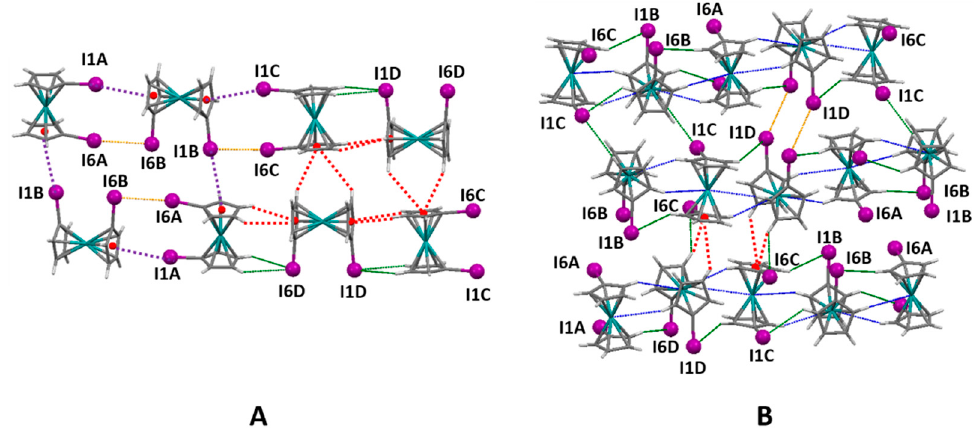
Figure 8. View of supramolecular arrangements of (CpI) 2 Ru (planes − 1,0,3 ( A ) and 1, − 1,1 ( B ).